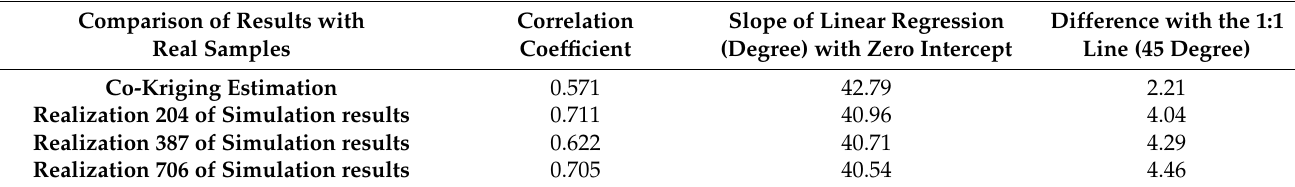
Figure 12. Maps of Al 2 O 3 concentration distribution in June–July: estimated (Co-kriging); and three different realizations of co-simulation. Table 6. Statistical parameters between validation samples (taken on 30 July 2019) and simulation results (three best realizations) and Co-kriging estimation of Al 2 O 3